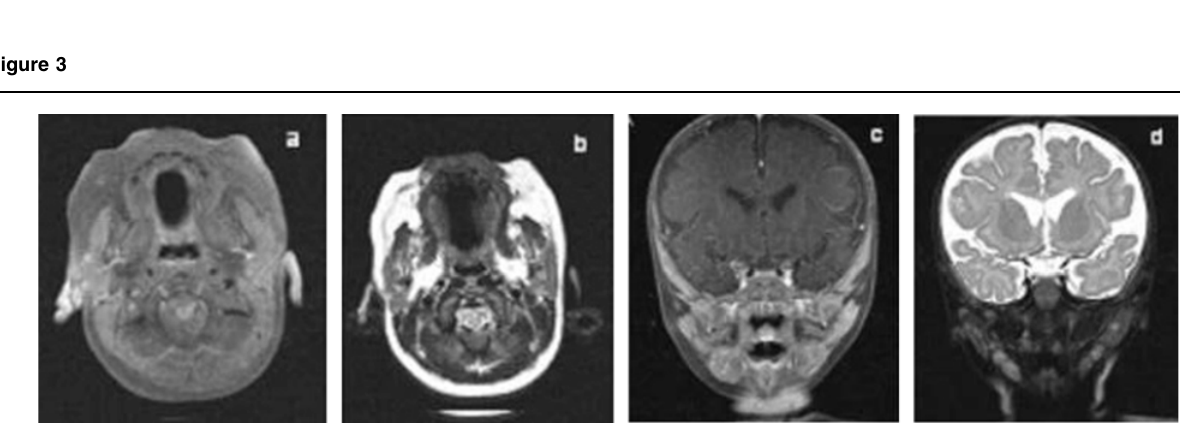
Collecting pus from the left parotid duct for microbiology.